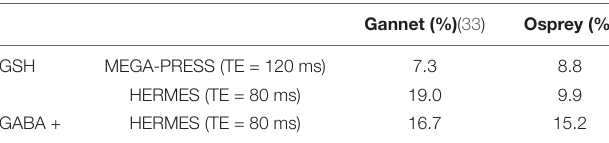
Gannet and Osprey.